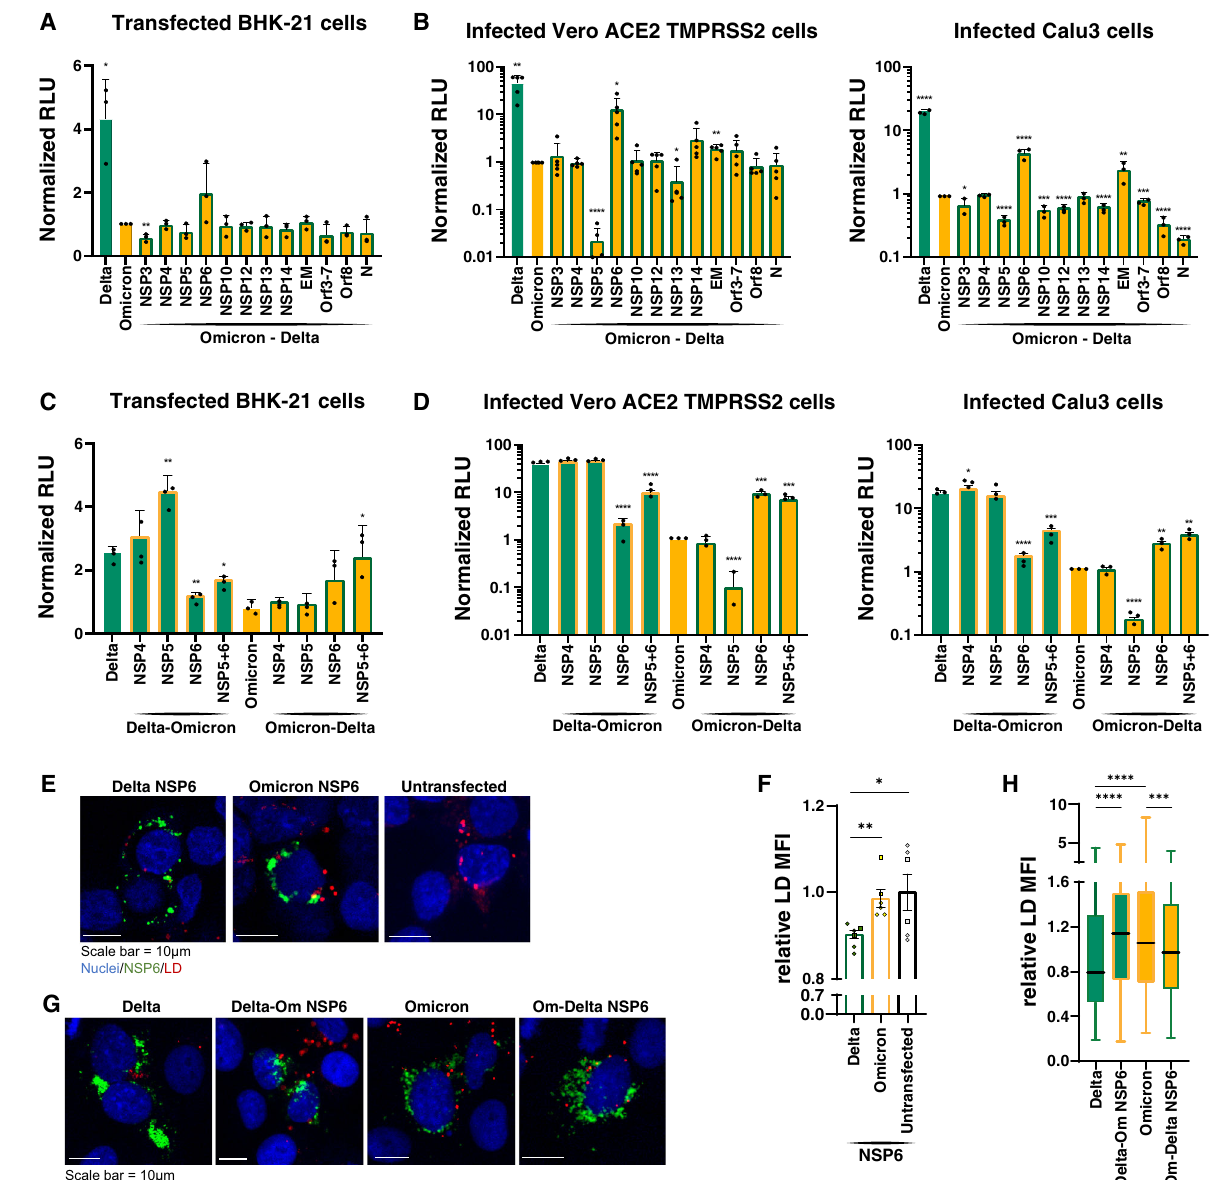
Fig. 5 | Omicron NSP6 slows viral RNA replication. A Luciferase readout from transfected BHK-21 with Delta, Omicron, and Omicron-Delta recombinants repli- cons as indicated and a Delta Spike and Nucleocapsid expression vectors. Average of three independent experiments analyzed in duplicate ± SD is shown, and pair- wise comparisons were made relative to the Omicron variant by two-sided Stu- dent ’ s T -test. B Luciferase readout from infected Vero ACE2 TMPRSS2 and Calu3 cellswithsupernatantfrom( A ).Averageof fi veandthreeindependentexperiments analyzed in triplicate and duplicate ± SD are shown for Vero ACE2 TMPRSS2 and Calu3 cells, respectively, and pairwise comparisons were made relative to the Omicron variant by two-sided Student ’ s T -test. C Luciferase readout from trans- fected BHK-21 with Delta, Delta-Omicron recombinants, Omicron, and Omicron- Delta recombinants replicons as indicated and a Delta Spike and Nucleocapsid expression vectors. Average of three independent experiments analyzed in dupli- cate ± SD is shown, and pairwise comparisons were made relative to the Omicron variant by two-sided Student ’ s T -test. D Luciferase readout from infected Vero ACE2 TMPRSS2 and Calu3 cells with supernatant from ( C ). Average of three inde- pendent experiments analyzed in duplicate ± SD is shown, and pairwise